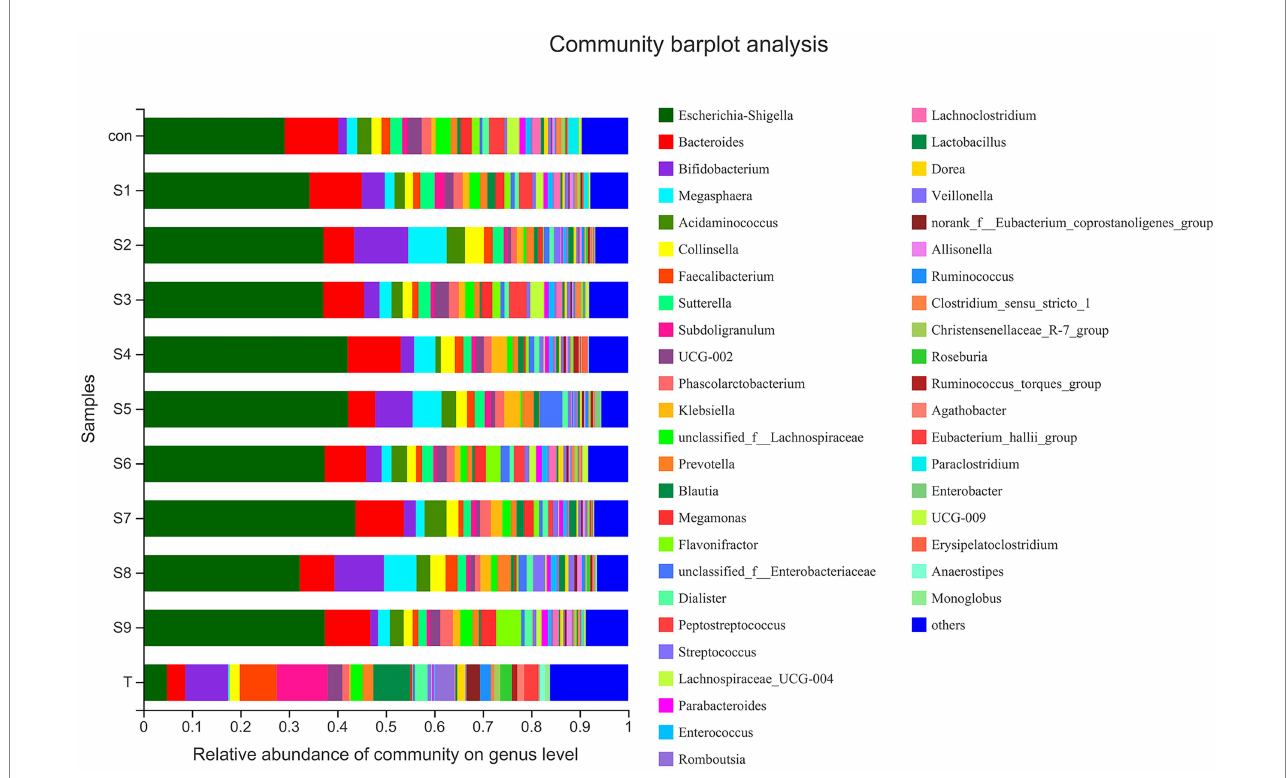
FIGURE 4 Composition of original fecal microbiota (T) and the abundance of fecal microbiota at the genus